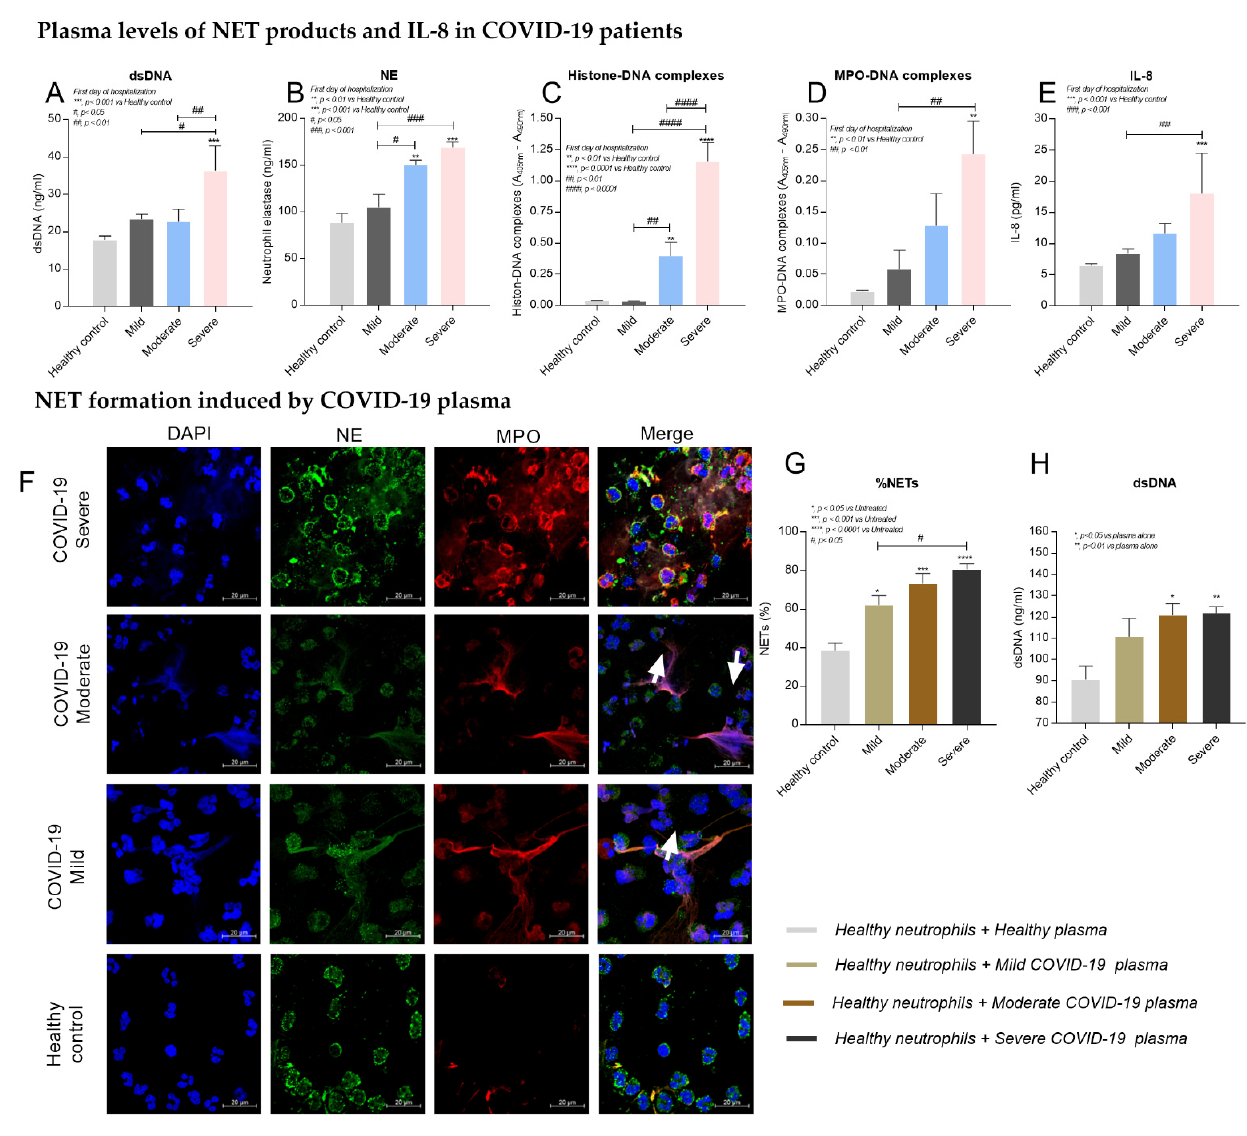
Figure 1. Plasma levels of NET products and IL-8 in COVID-19 patients and NET formation induced by COVID-19 plasma. The levels of extracellular double-strand DNA (dsDNA) ( A ), neutrophil elastase (NE) ( B ), Histone–DNA complexes ( C ), MPO–DNA complexes ( D ) and IL-8 ( E ) in COVID-19 patients with mild symptoms, moderate pneumonia, severe pneumonia, and healthy controls ( n = 10 for all groups). Representative fluorescence images captured by confocal microscopy (original magnification 630Xand scale bars indicated object size as labelled 20 μ m) of isolated neutrophils from healthy controls incubated with COVID-19 plasma or healthy control plasma ( n = 10 for all groups), stained with DAPI (blue), neutrophil elastase (green) and myeloperoxidase (red), and merged images for NET identification ( F ). The percentages of NETting neutrophils ( G ) and the levels of dsDNA ( H ) from healthy neutrophils incubated with COVID-19 plasma or healthy control plasma (Supplemental Table S1). (* p < 0.05, ** p < 0.01, *** p < 0.001, **** p < 0.0001 vs. healthy control and # p < 0.05, ## p < 0.01, ### p < 0.001, #### p < 0.0001 vs. the indicated group).